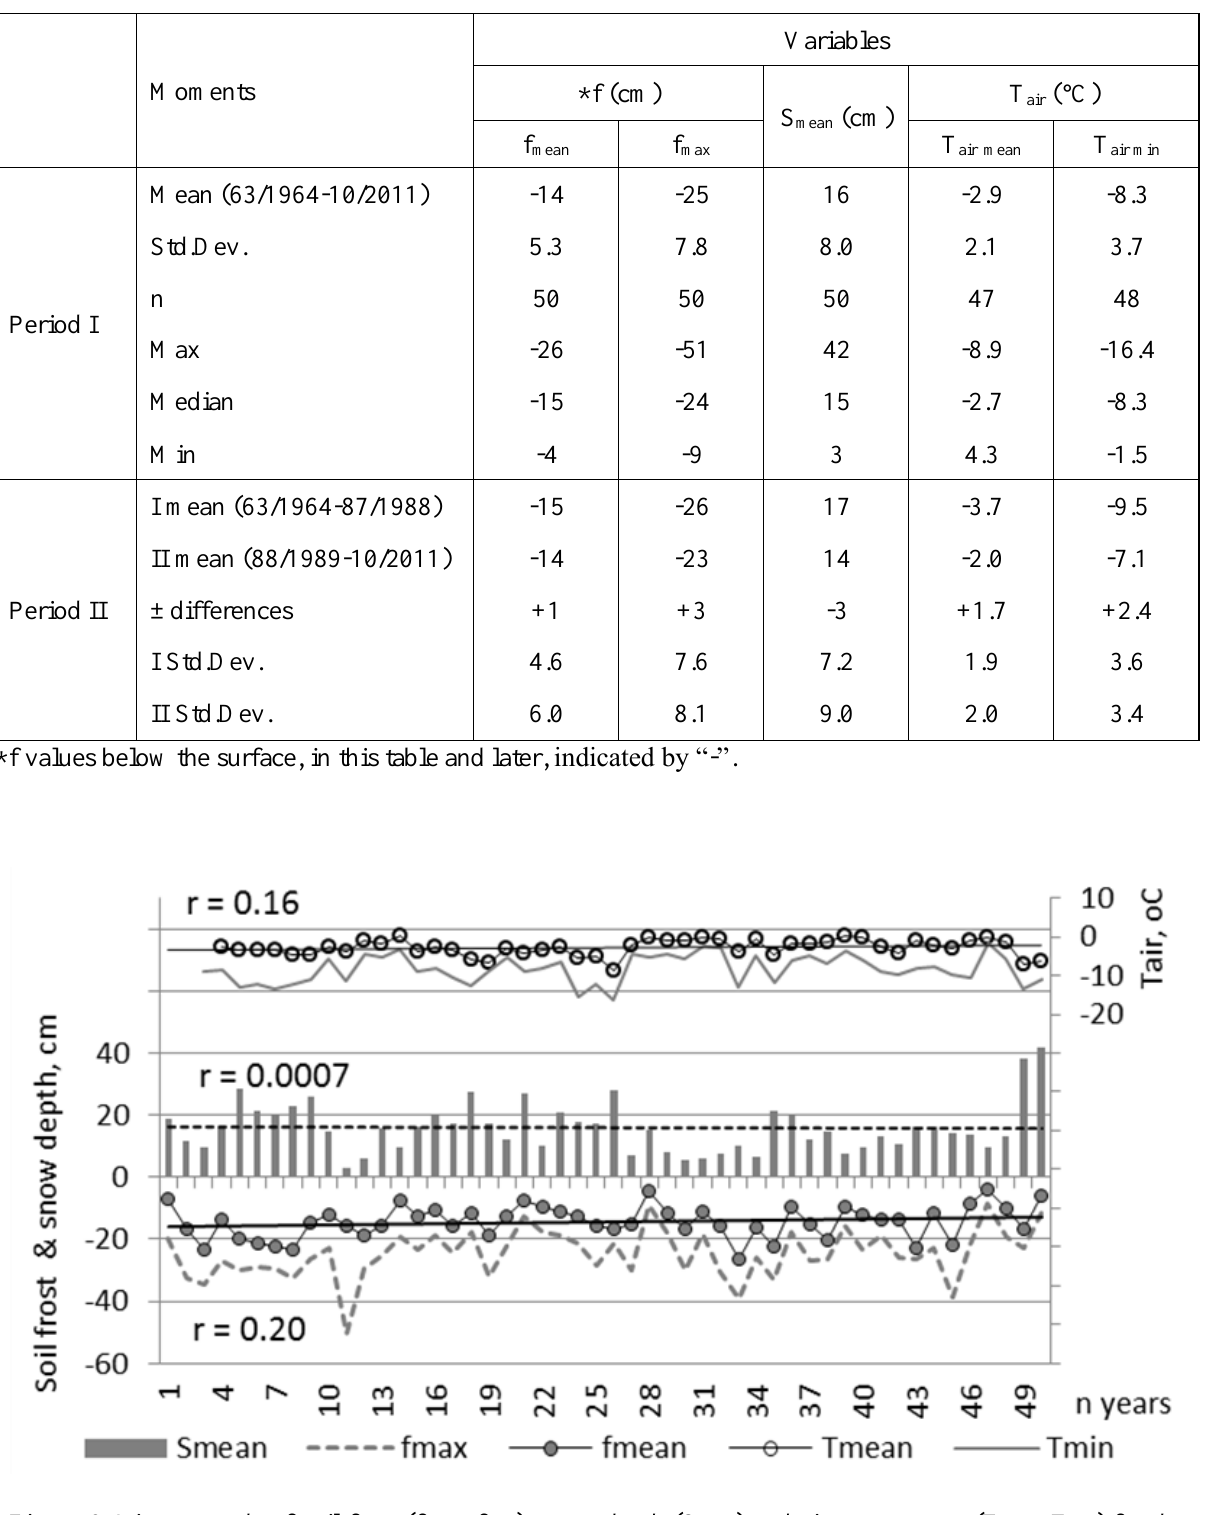
, f ), snow depth (S mean max